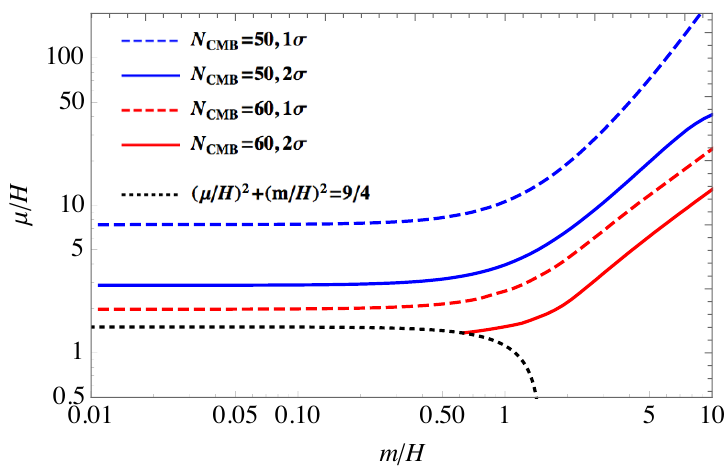
Figure 6 . Constraints on the m (cid:0) (cid:22) parameter space from the combination of the Planck data and the BICEP/Keck data [45], where the blue curves are for N CMB = 50 and the red curves N CMB = 60. The regions above the curves are